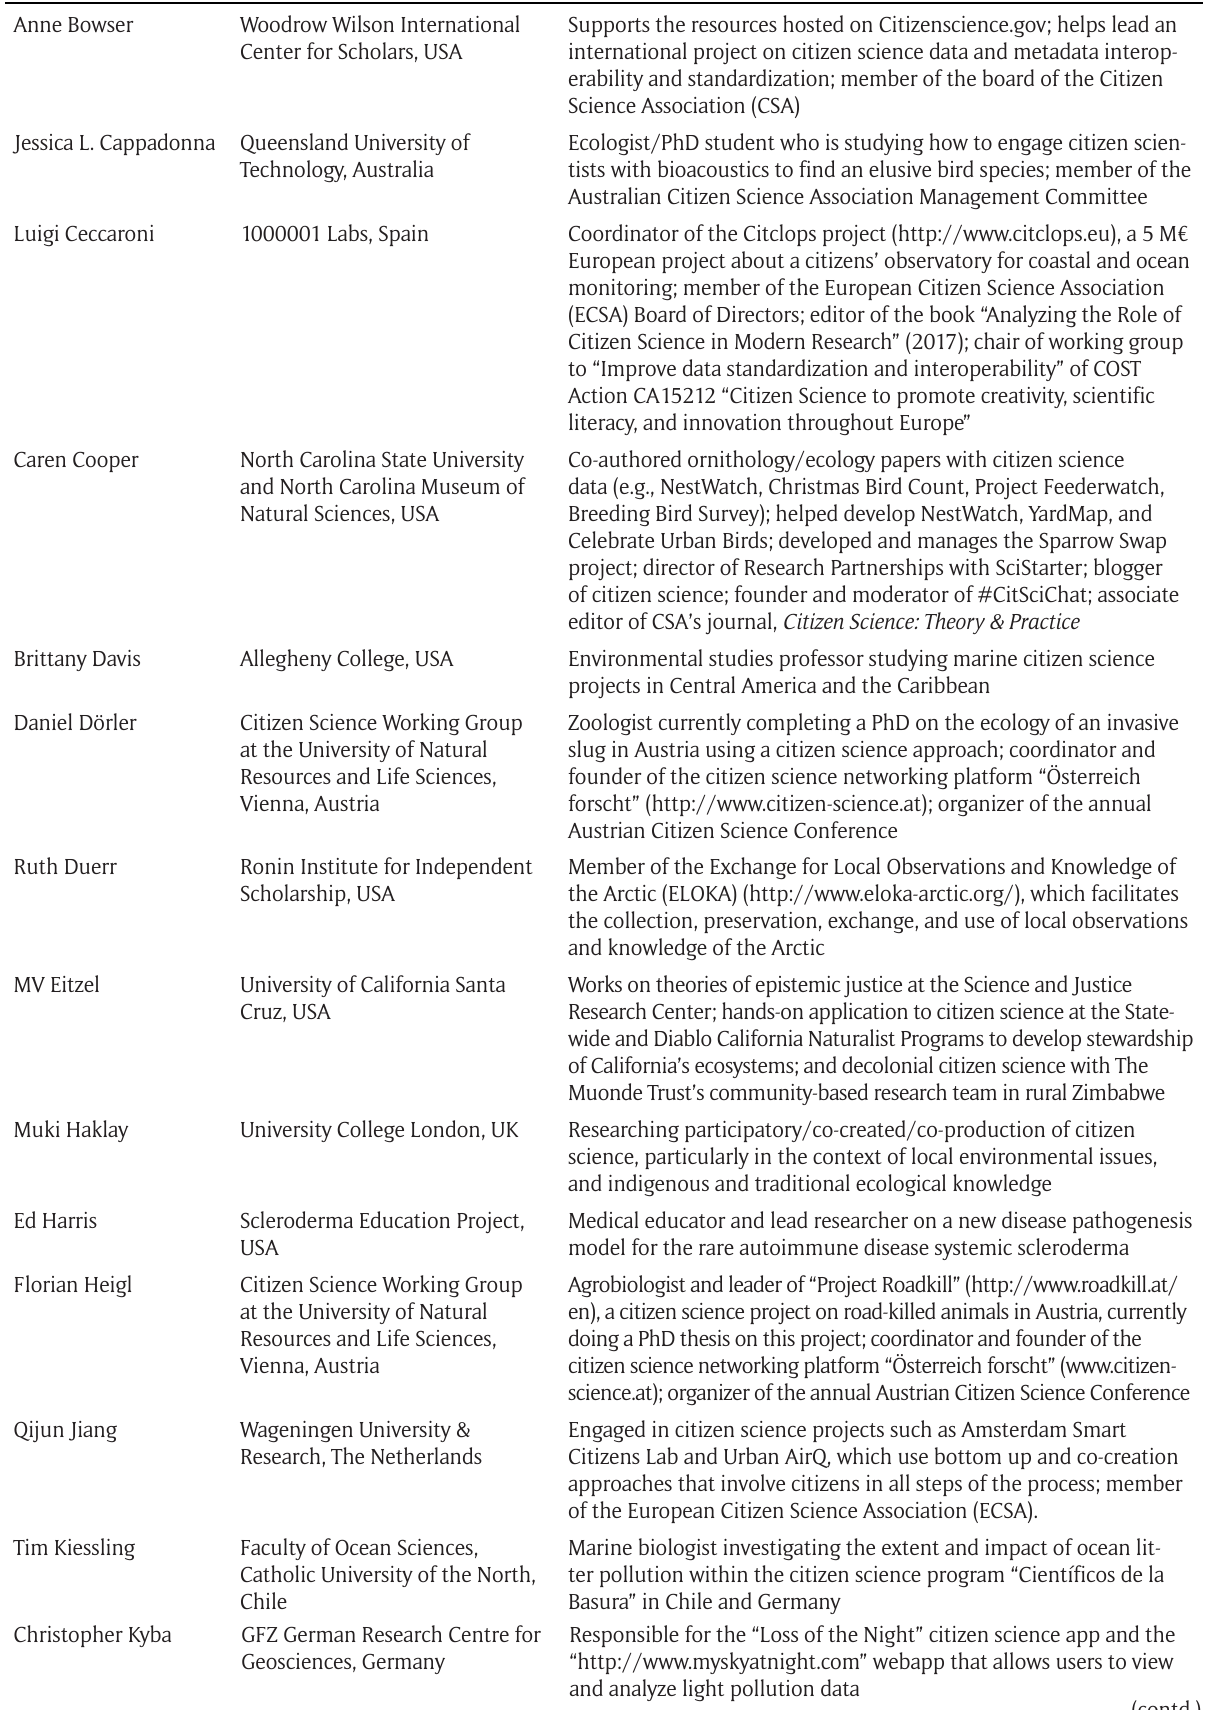
Table 1: Authors’ affiliations and commitments to citizen science, in alphabetical order by last name. Author